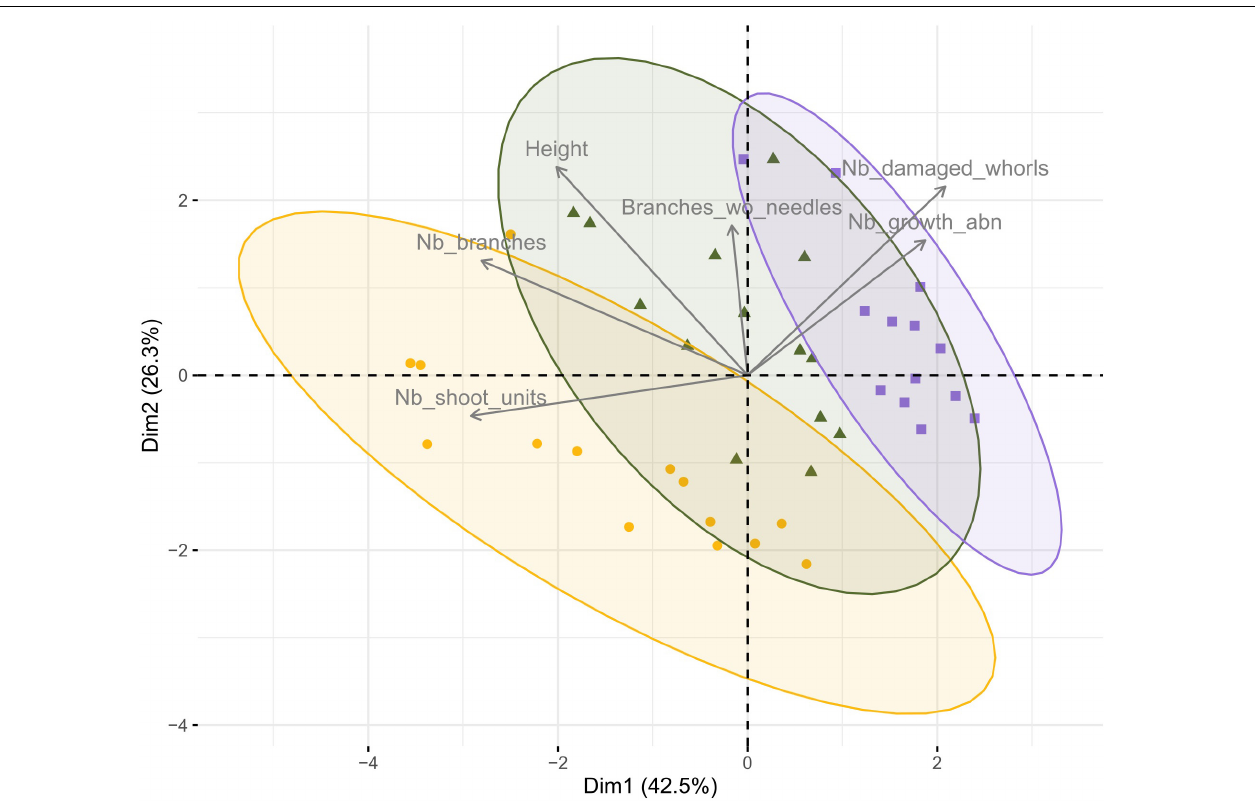
FIGURE 2 | Principal component analysis of pine architecture variables ( Table 1 ). The plot shows the first and second axis, which together explained 68% of the variance. Arrows (and corresponding names) represent the architectural traits (Nb_shoot_units = number of shoot units, Nb_branches = number of branches, Height = tree height, Branches_wo_needles = branches without needles, Nb_damaged_whorls = number of damaged whorls and Nb_growth_abn = number of growth abnormalities). Dots correspond to the individual trees. Shape and color represent the different levels of browsing (orange circles = control, green triangles = moderately browsed, blue squares = intensively browsed). Ellipses are drawn at the 95% confidence level according to browsing intensity.